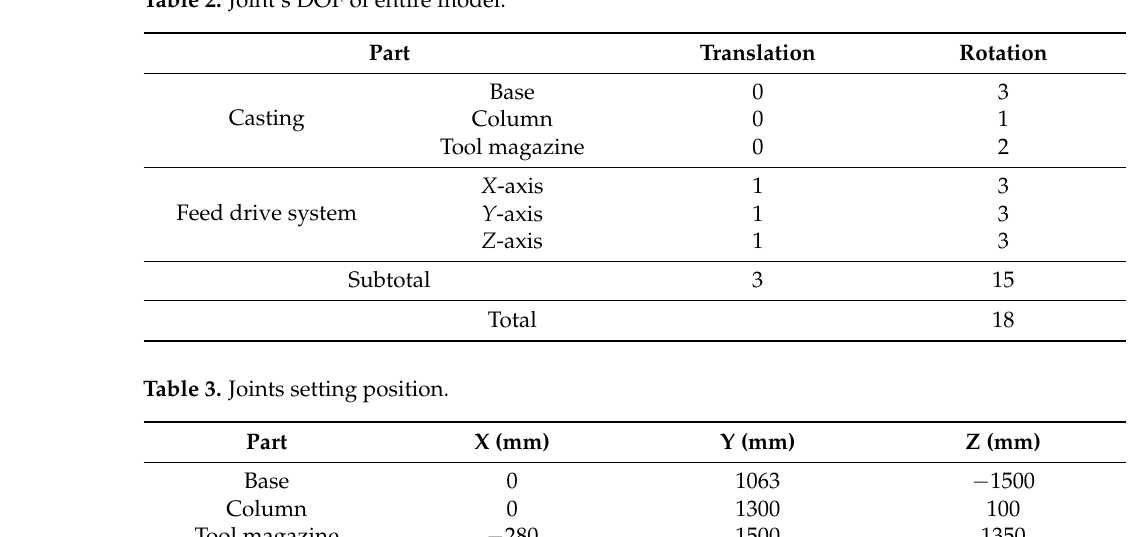
Figure 12. IDDP results for base: ( a ) total rotational axes for each frequency; ( b ) the intersection for the joint position. Table 2. Joint’s DOF of entire model.